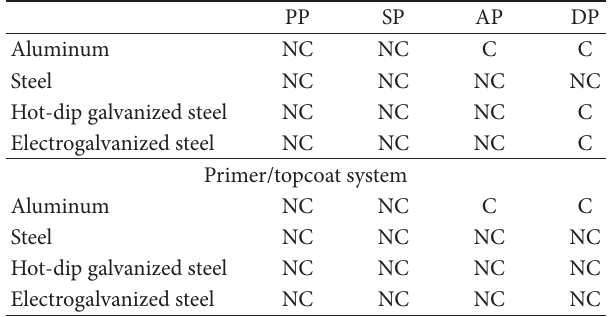
Table 5: Results of the lattice method. Table 6: Resistance of the coating during bending on a cylindrical